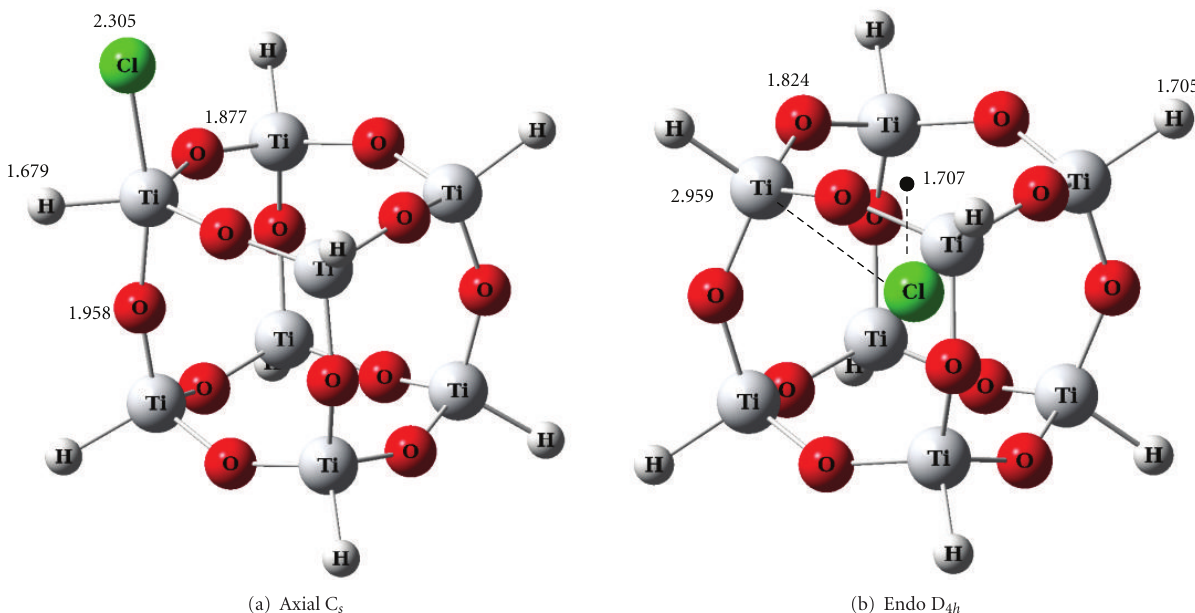
Figure 5: The B3LYP/6-311+G(d) optimized geometries of the exohedral (Axial) and endohedral (Endo) complexes of Cl − and Ti-T 8 in